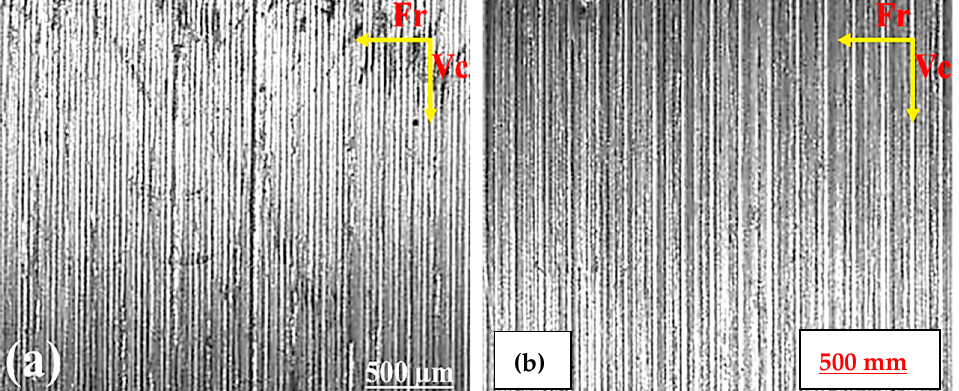
Figure 3. ( a ) Compound microscopical surface texture at the low time variable, producing low surface roughness at 0.3 mm/ revfeed, 120 rpm speed, 2 mm depth of cut, and 4 min time. ( b ) Higher surface roughness at 0.3 mm/ revfeed, 60 rpm speed, 4 mm depth of cut, and 8 min time.